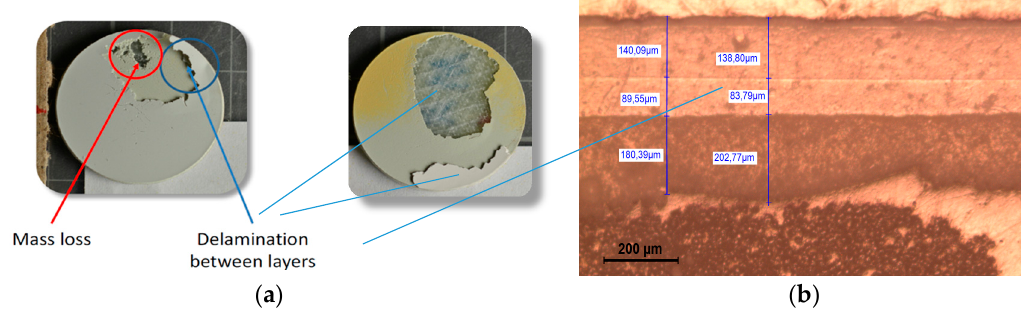
Figure 10. ( a ) Two different types of erosion failure: pits and cracks that progress with mass loss caused by direct impact and stress on surface (left) and delamination indirectly caused by the interface stresses (right); ( b ) Cross section of a multi-layered system. Two consecutive coating layers and coating–substrate interfaces in which delamination tend to appear upon impingement.